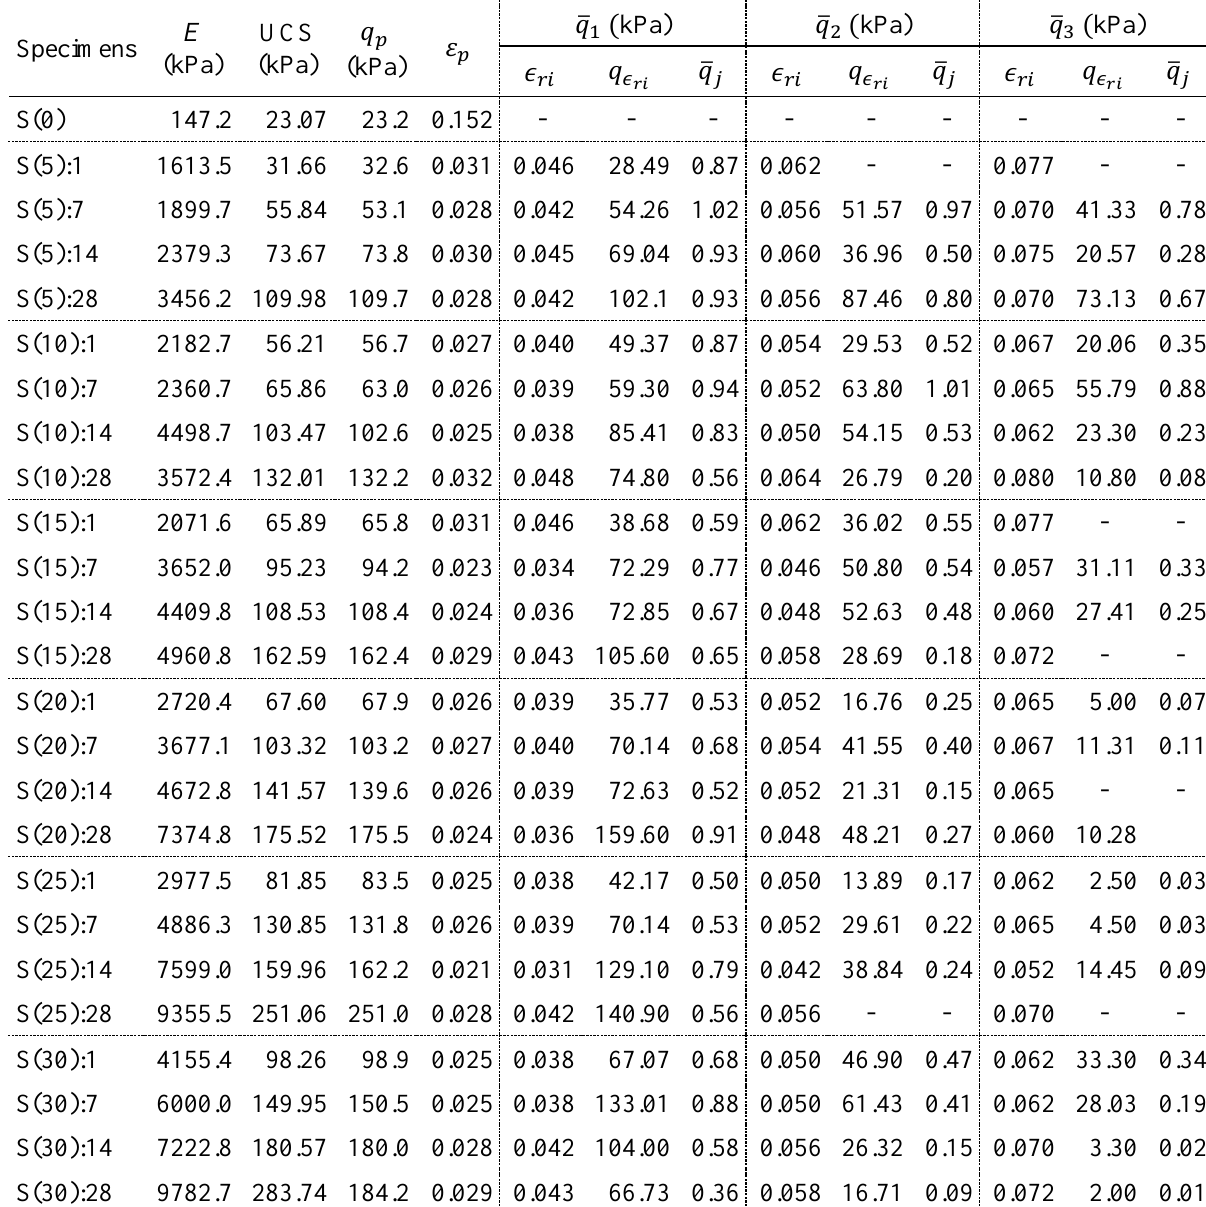
Table 5. Testing diet and results. E = secant elasticity modulus, UCS = Unconfined Compressive Strength, q p = peak unconfined strength, and ε p = axial strain at peak. The remaining columns show retained compressive strength on post-peak straining; see text for further